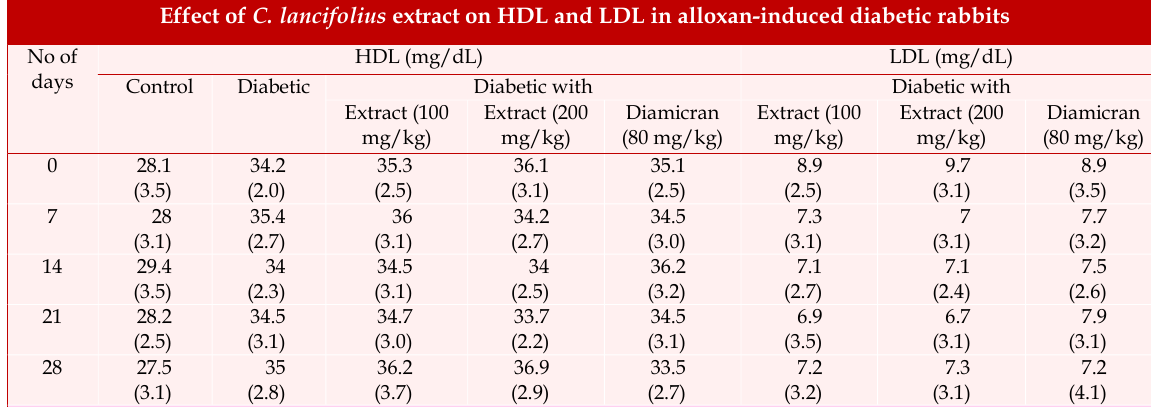
Effect of C. lancifolius extract on HDL and LDL in alloxan-induced diabetic rabbits